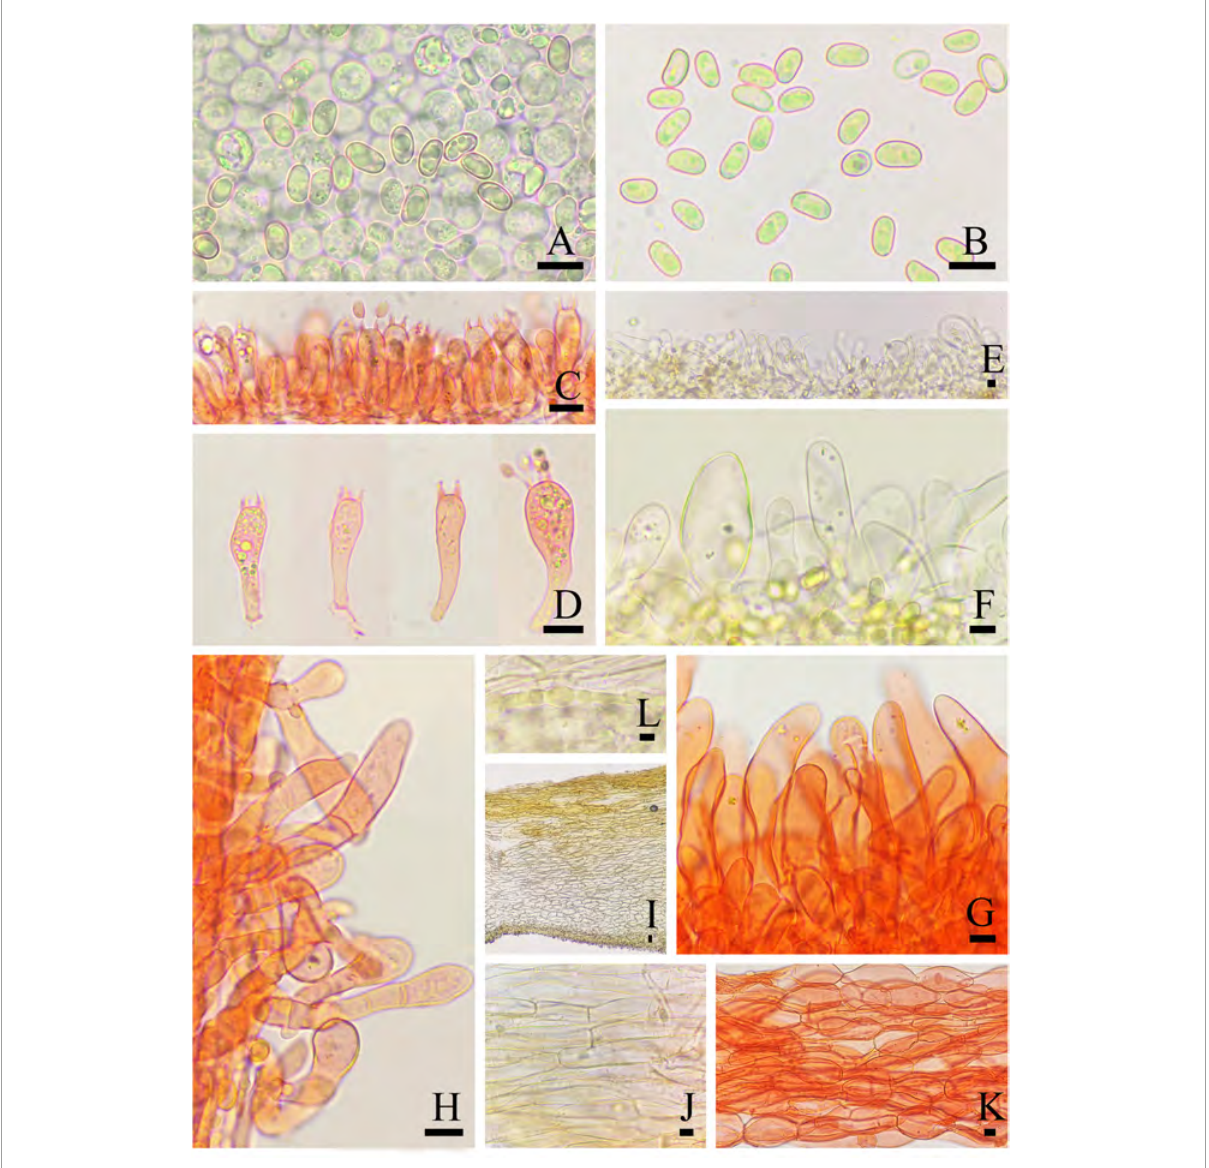
FIGURE3 Microscopic features of Inosperma nivalellum (MHHNU31689, holotype). (A,B) Basidiospores; (C,D) basidia with probasidium; (E) gill edge; (F,G) cheilocystidia; (H) caulocystidia; (I) transverse section of pileus; (J) pileipellis; (K) hymenial hyphae; and (L) oleiferous hyphae. Scale bars = 10 µ